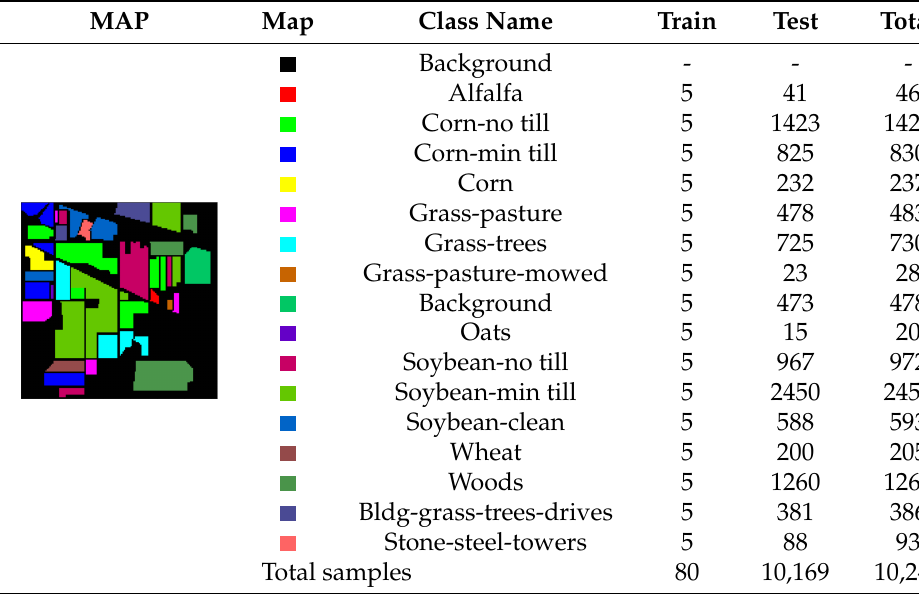
Table 1. Sample labels and sample size for the Indian Pines dataset.